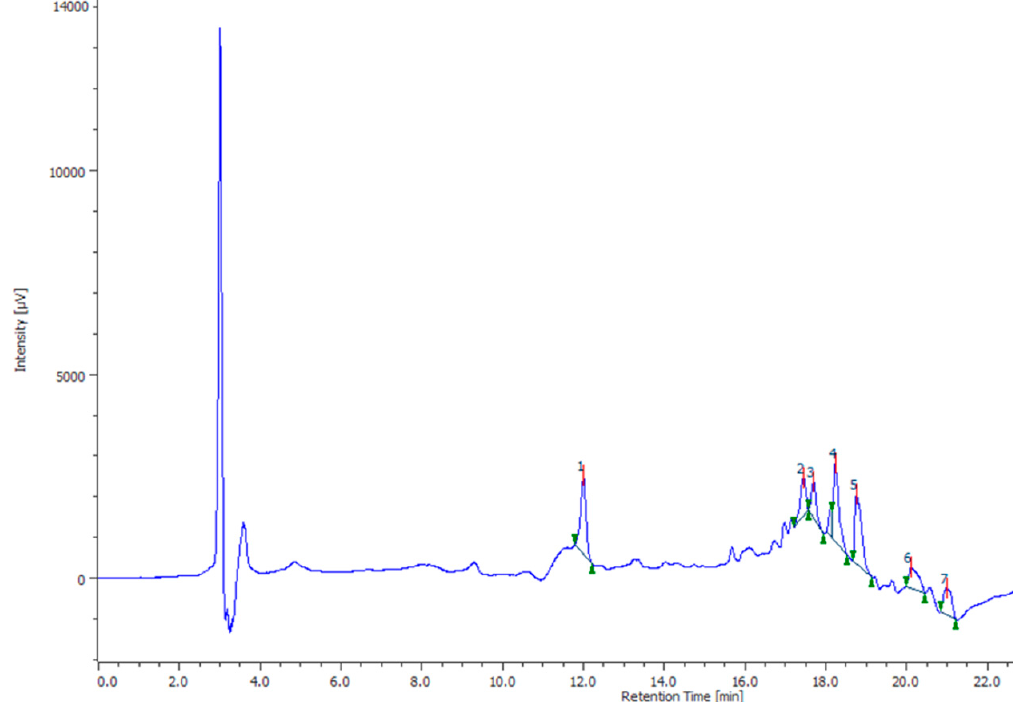
Figure 1. HPLC-DAD analysis of phenolics present in the water extract of Futura 75 hemp variety. Specifically, vanillic acid (2), ferulic acid (4), rutin (5) and naringenin (6) were identified through comparison with standard solutions.